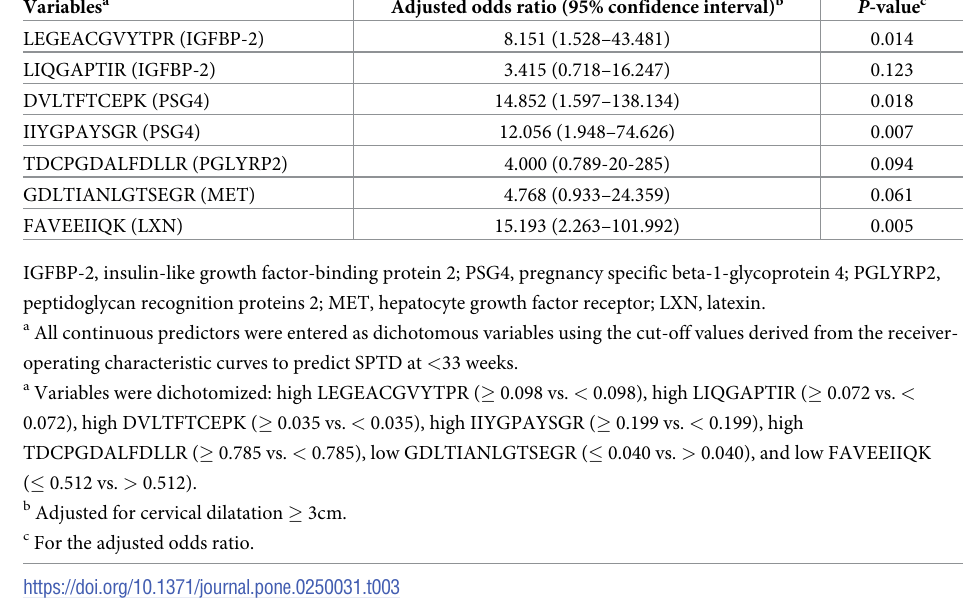
Table 3. Multivariable logistic regression model showing the adjusted odds ratios of association between various proteins in maternal plasma and spontaneous preterm delivery at < 33 weeks after adjusting for advanced cervical dilatation ( � 3cm).